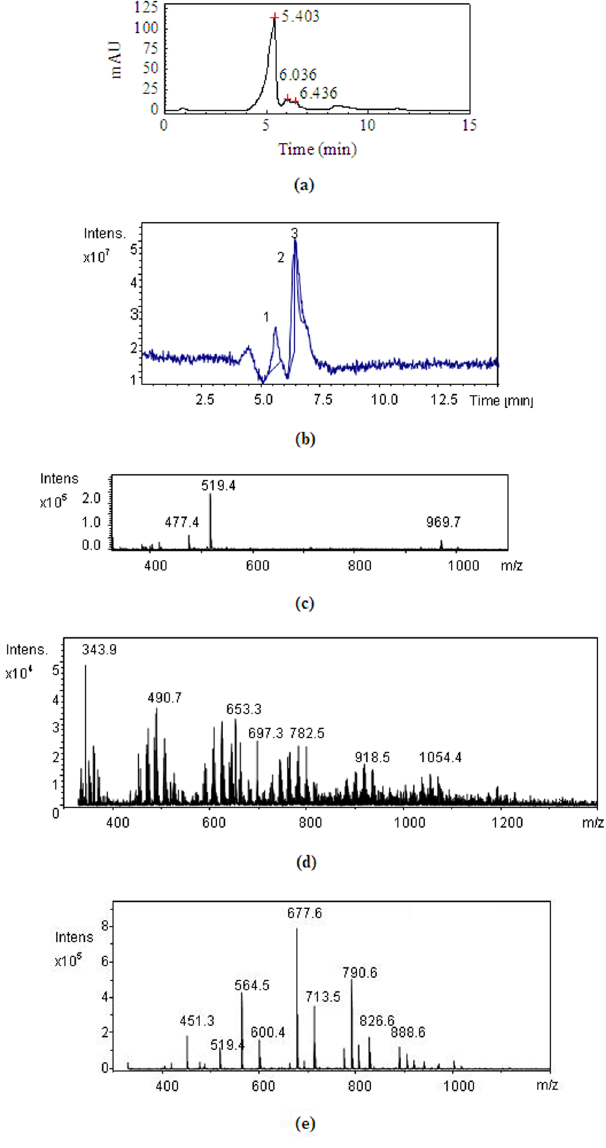
Figure 12. HPLC chromatograms of BP ( a ), total MS of BP ( b ), MS of BP at 4.3–4.7 min ( c ), MS of BP at 5.3– 5.9 min ( d ) and MS of BP at 6.1–6.4 min ( e